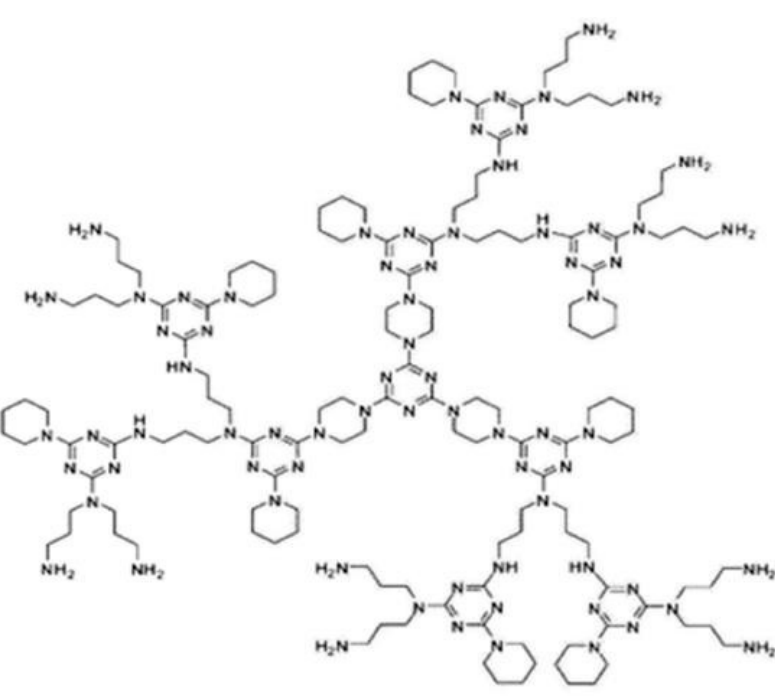
Figure 3. NS 3 [ p ] polymer de Figure 3. 𝑁𝑆 (cid:2871) [𝑝] polymer de ndrimer.